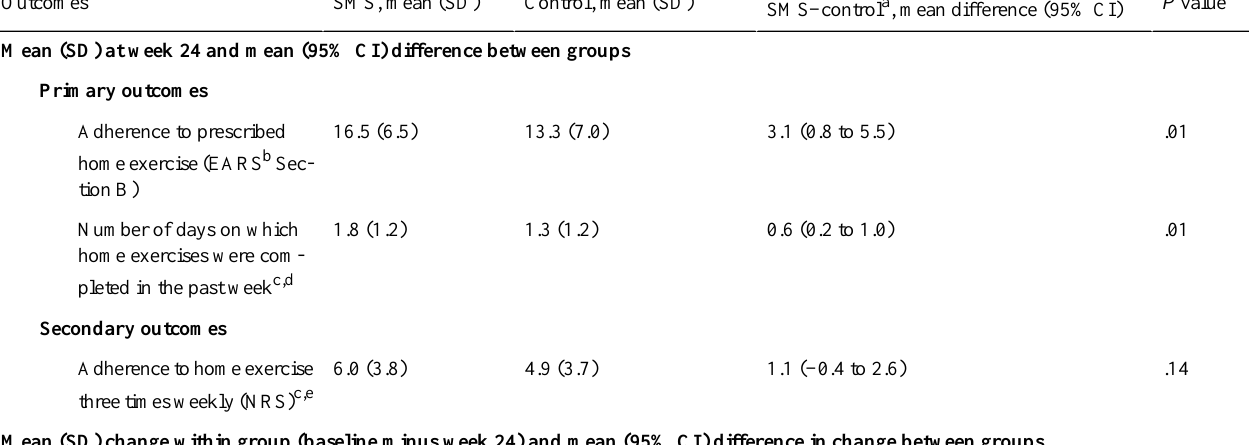
Table 3. Mean (SD) scores at week 24 or mean (SD) change within groups, from baseline to week 24, and mean (95% CI) difference between groups (adjusted for baseline value of outcome, TARGET exercise group, and dichotomized baseline adherence), for continuous outcomes, using multiply imputed